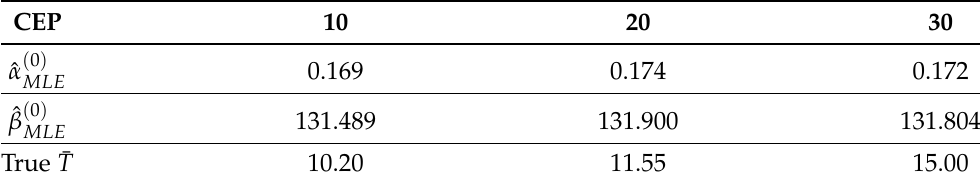
Table 3. Initial parameter estimates on Type-II censored Fatigue Life data.